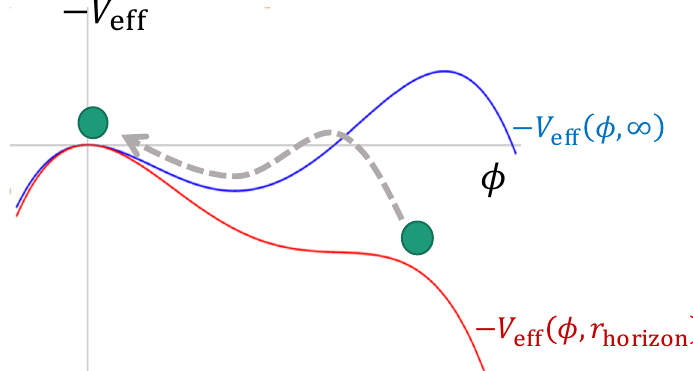
Figure 4 . The Euclidean dynamics of the scalar (cid:12)eld is shown. The red line represents the (cid:13)ipped e(cid:11)ective potential at the horizon, which is stabilized by the thermal mass and the true vacuum is absent. At a distant region, the (cid:13)ipped e(cid:11)ective potential is lifted as the thermal e(cid:11)ect becomes weaker (blue line). Therefore, even if the true vacuum is absent near the horizon, a bounce solution can be constructed by using the shooting method (gray dashed